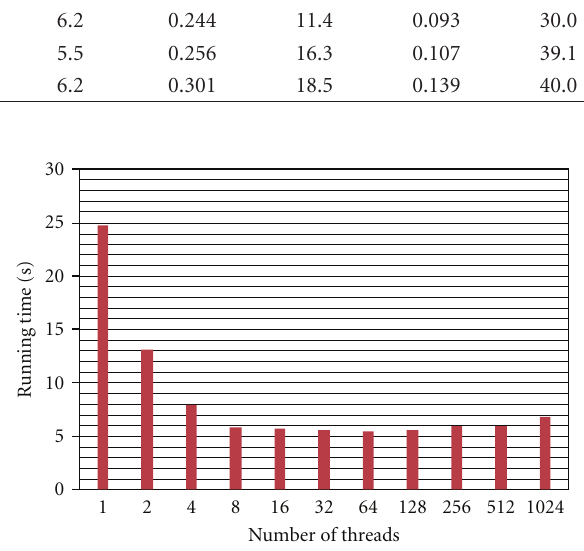
Figure 7: Running times (in seconds) for the multithreaded CPU implementation of our